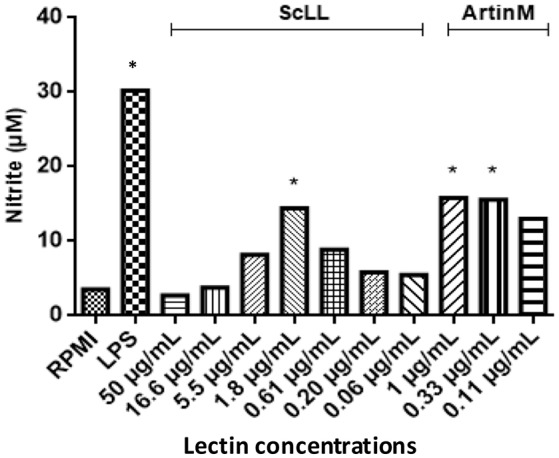
Nitric oxide production in supernatants from bone marrow-derived macrophages (BMDMs) cultures after 48 h of stimulation with different concentrations of ScLL or ArtinM and LPS (1 μg/mL). Cells were stimulated with ScLL (50; 16.6; 5.5; 1.8; 0.61; 0.20; and 0.06 μg/mL) or ArtinM (1; 0.33 and 0.11 μg/mL). Nitrite concentration measured by Griess Reaction. The data are representative of one from three independent experiments in triplicate for each condition. *Statistically significant in relation to the control (RPMI-1640). (ANOVA and Tukey's multiple comparison post-test; P < 0.05).